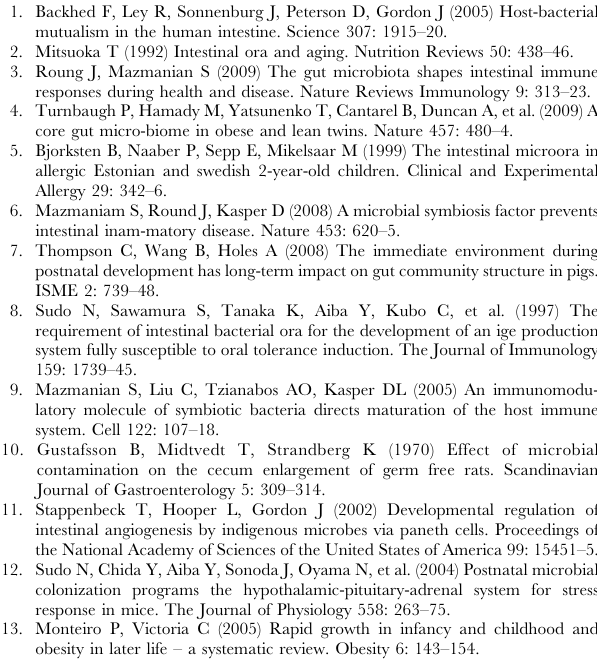
Table S1 Probes and the frequency of their detection. The frequency of the detection of each probe, stratified by sex and day. Information is presented as percent detected.